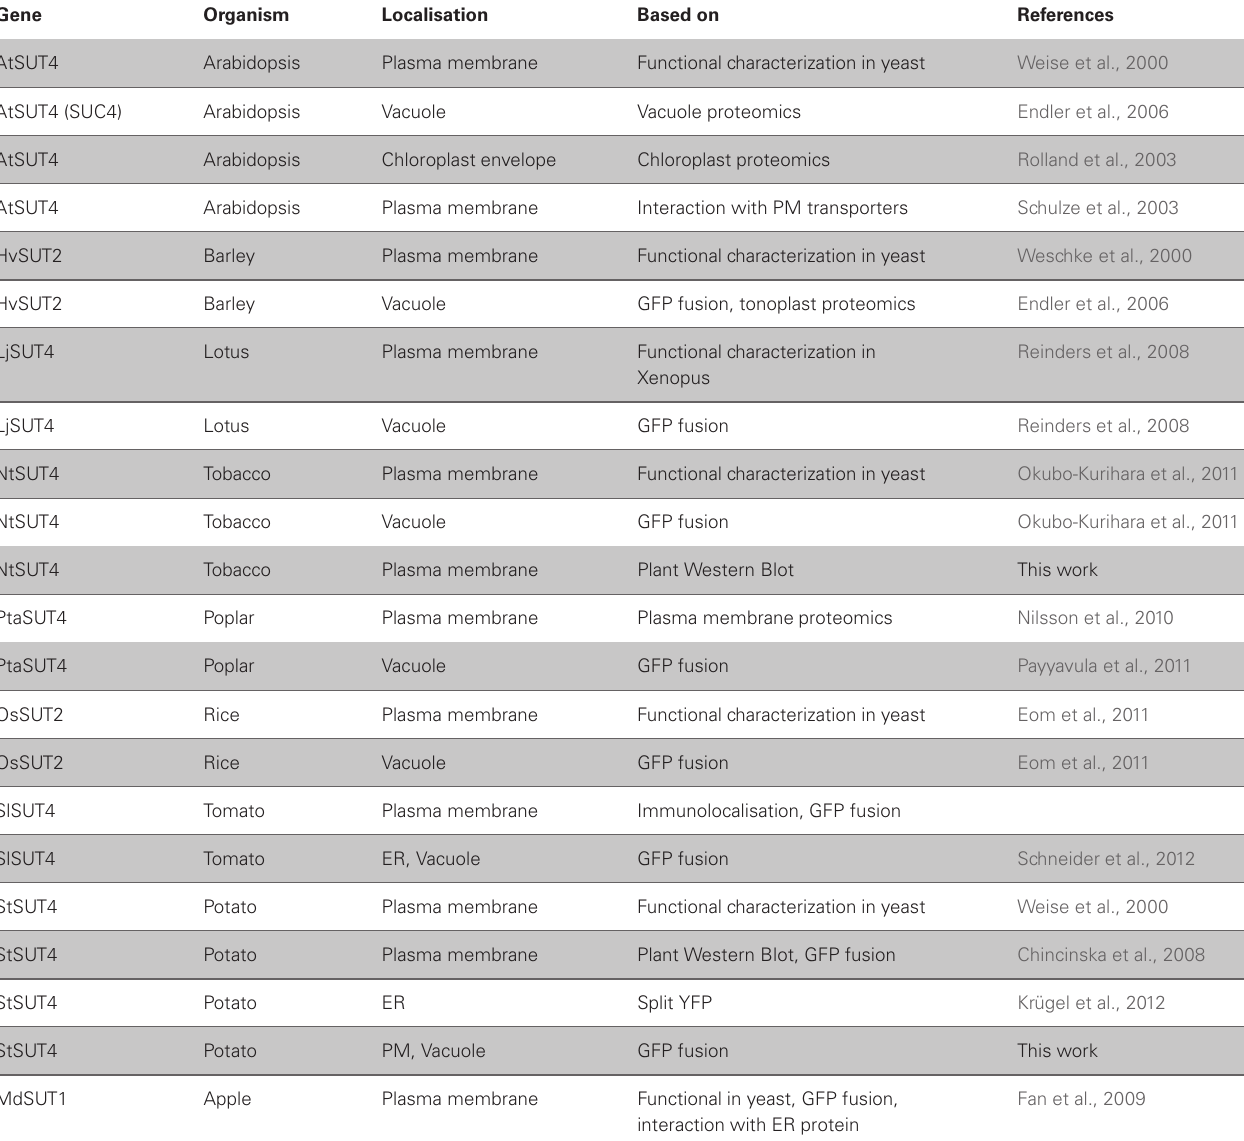
Table 1 | Functional characterization of members of the SUT4 subfamily of sucrose transporters reveals a different localization than GFP